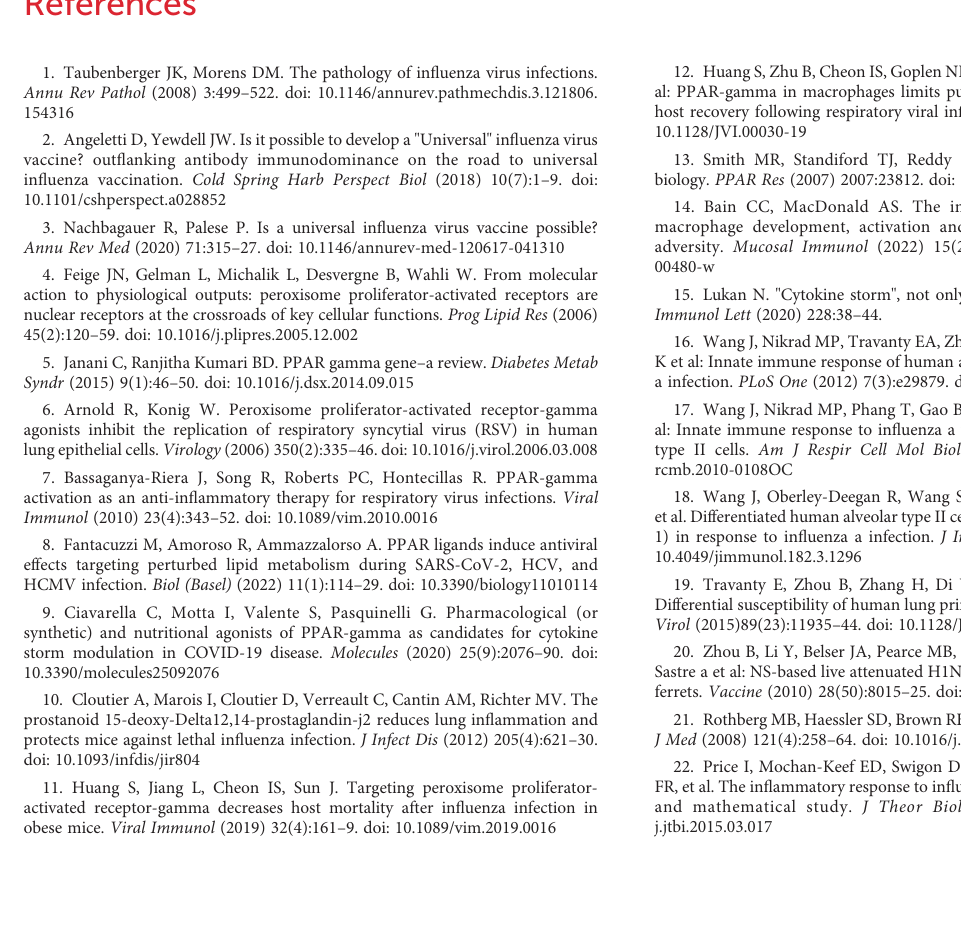
SUPPLEMENTARY FIGURE 1 PPAR g agonist inhibits H3N2 induced secretion of IL-8 and TNF a but not IP-10. Isolated human AMs were treated with PPAR g agonist, troglitazone (5 m M) in human Ams after H3N2 virus infection. After infection, cells were cultured with troglitazone for another 24 h. At 24 h after infection, cell- free culture supernatants were collected to detect cytokines using DuoSet ELISA kits from R&D Systems. (A) IL-8. (B) TNF a . (C) IP-10. Unpaired t test was applied for the statistical analysis.